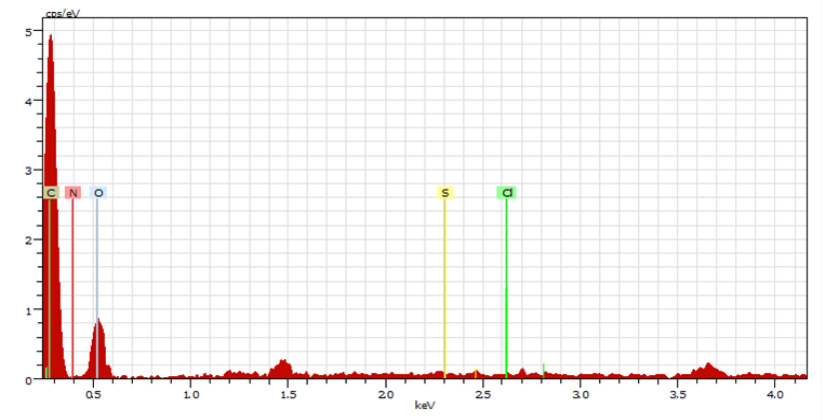
Figure 2. Energy Dispersive X-ray spectra and Atom Percent of SEGT.